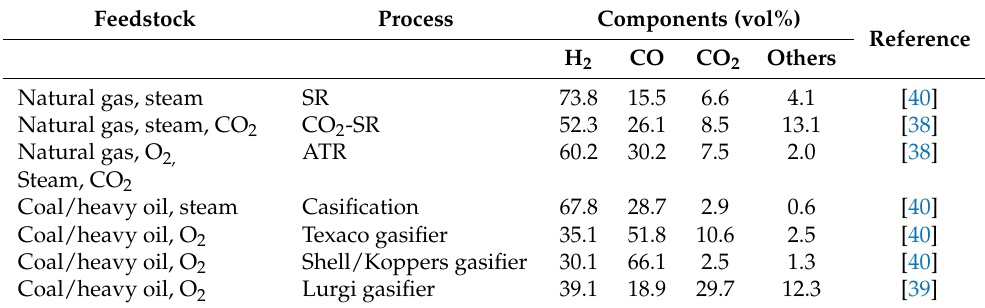
Table 1. Synthesis gas